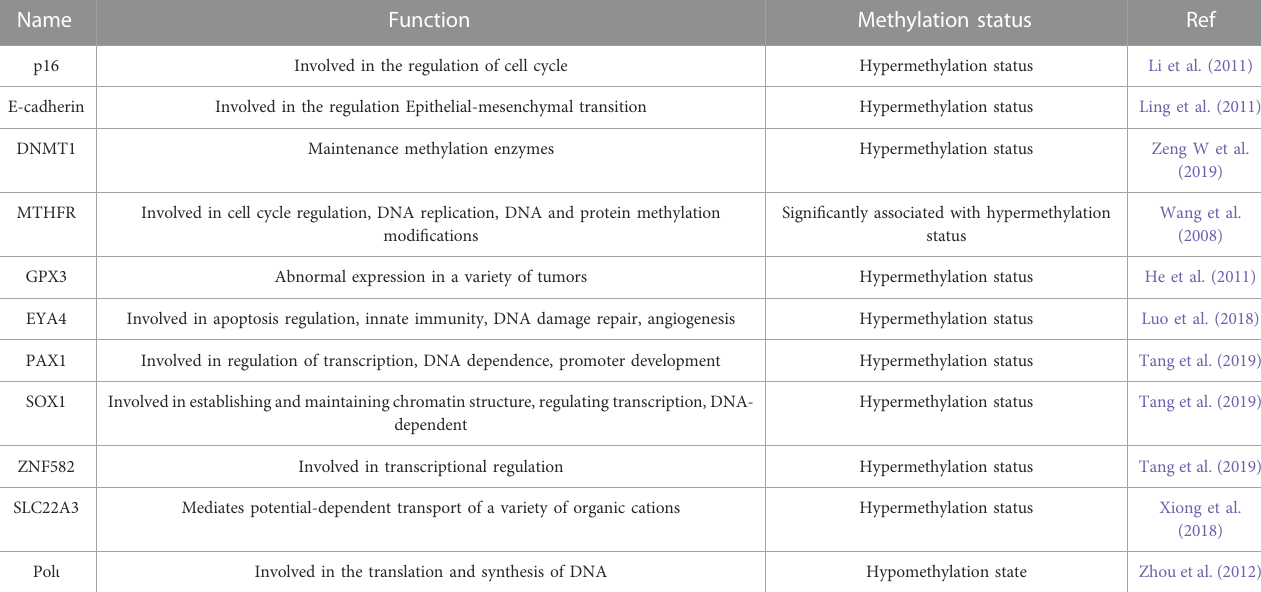
TABLE 1 Biomarkers of abnormal DNA methylation in esophageal